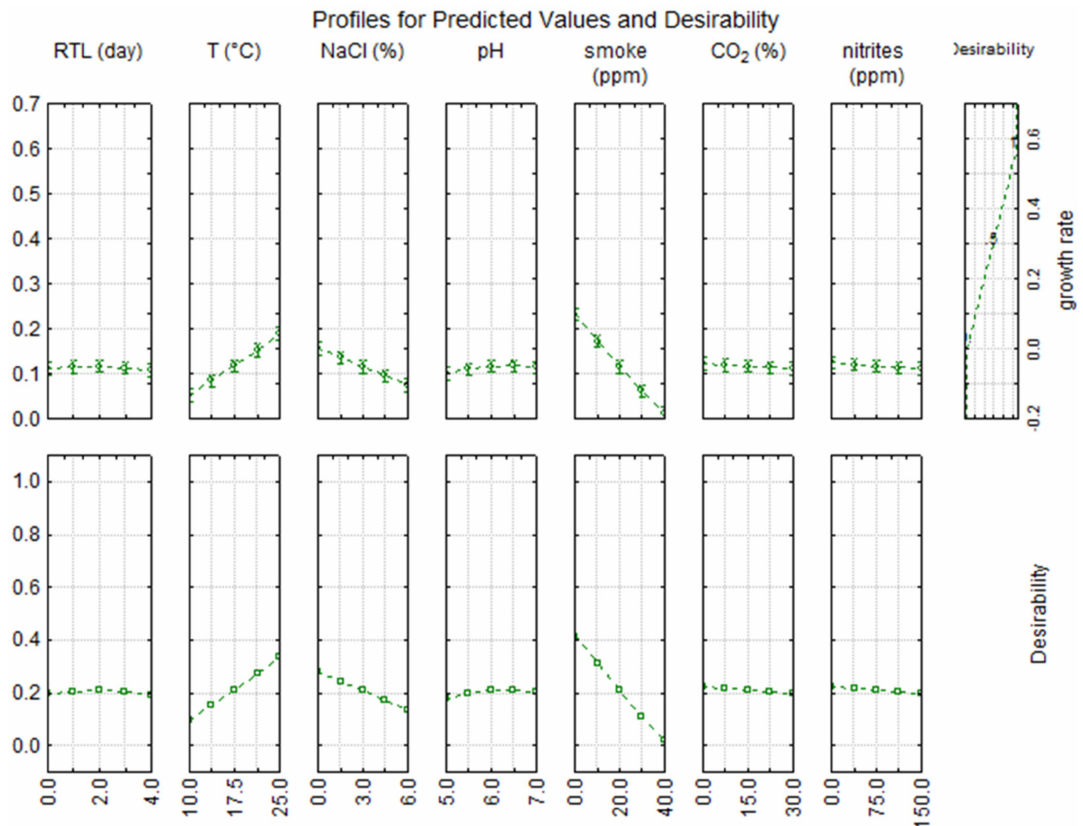
Figure 3. Desirability profile for the maximal growth rate ( µ max ) of lactic acid bacteria in fish